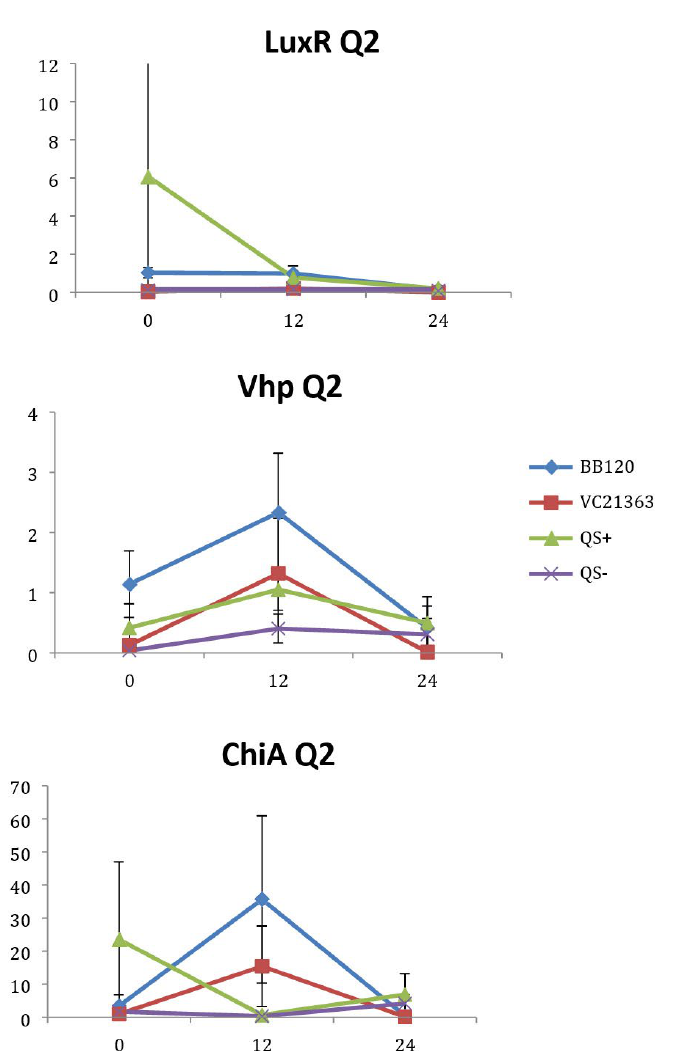
Fig. 2. Relative gene expression levels of luxR, vhp and chiA over a 24h period in treatment with Skeletonema 4x10 5 cells per ml and Vibrio =10 4 cells per ml). Y-axis= Relative expression to RpoA, X-axis= Time elapsed (hr). Error bars represent standard error of